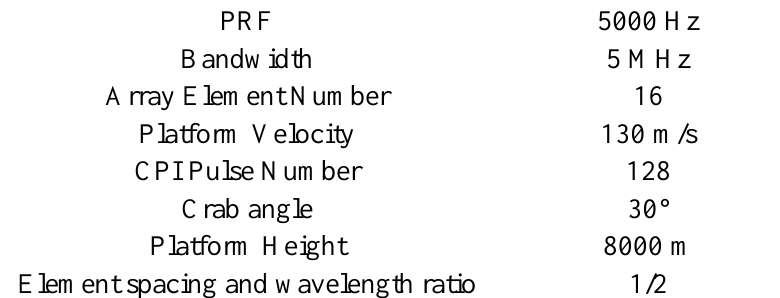
Table 1. Simulation Parameters for AEW